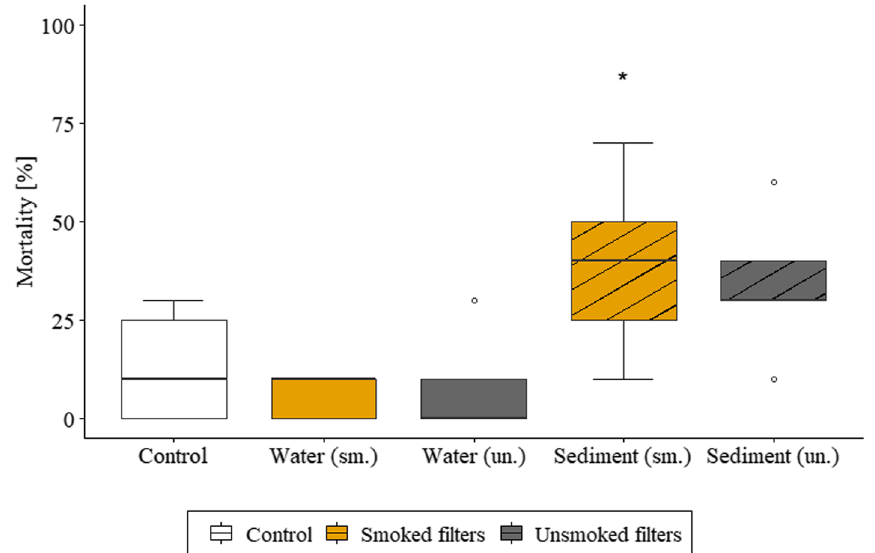
Fig. 4 Larval mortality following the 7-day exposure. Mortality is presented as percent mortality in a replicate ( n N 35). The boxes display the 25%- and 75%-quartile, dark lines the median, and the whiskers extend to one and a half times the interquartile = range. Striped boxes represent the sediment treatment groups; white circles represent outliers. The asterisk indicates evidence for increased mortality in the treatment group compared to the control with p < 0.05 for (*), based on Tukey HSD